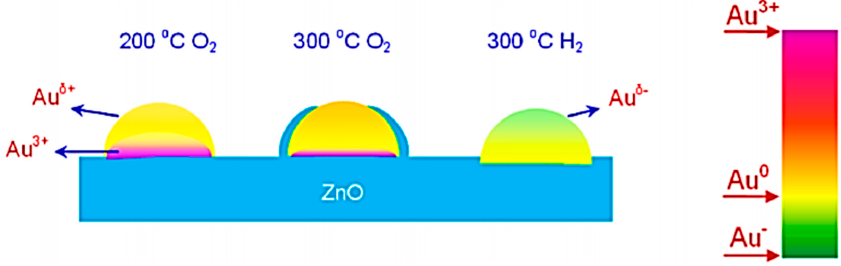
Figure 3. Schematic illustration for the strong metal ‐ support interactions (SMSI) states in the Au/ZnO nanorod system under various pretreatments. The color bar depictsthe sign and degree of charging of the gold nanoparticles. Reproduced with permission from [139]. Copyright American Chemical Society, 2012.